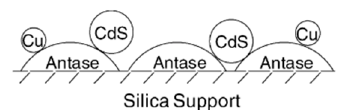
Figure 17. Illustrated material fabricated by Shi et al. Reprinted from [33], Copyright (2004), with permission from Elsevier. Table 4. Photocatalytic conversion of methane and carbon dioxide over the catalyst in Figure 17. Reprinted from [33], Copyright (2004), with permission from Elsevier.